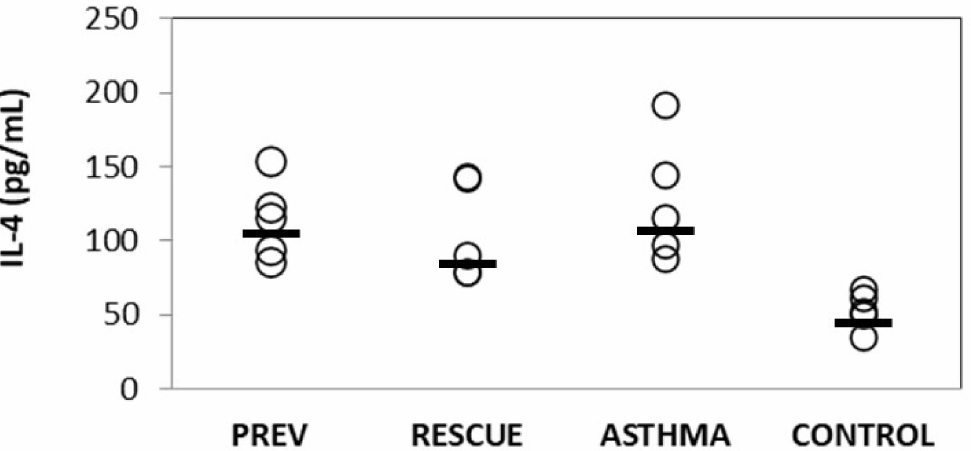
Figure 4. Variation of IL-4 levels in broncho-alveolar lavage fluid (Abbreviations: IL-4 = interleukin 4; PREV = long-term low-dose vitamin D supplementation, RESCUE = short-term high-dose vitamin D supplementation, ASTHMA = positive control, CONTROL = negative control. Note: circles = individual values; horizontal line =